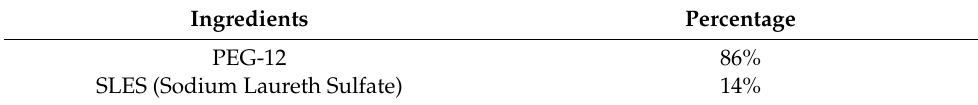
Table 3. Formula TO SKIN—Best two ingredients.